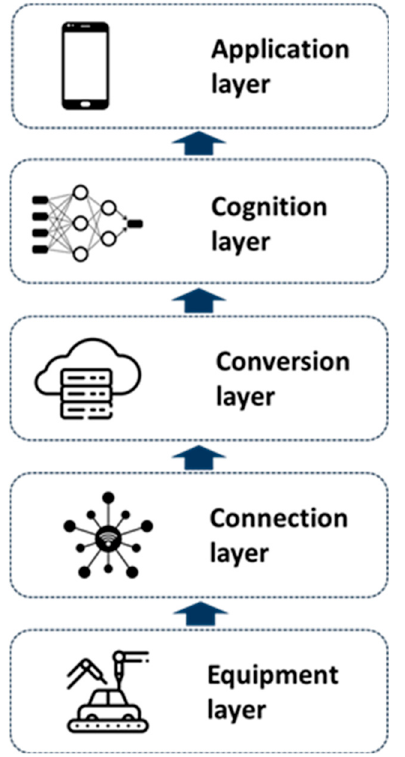
Figure 1. Hierarchy of the smart manufacturing system.